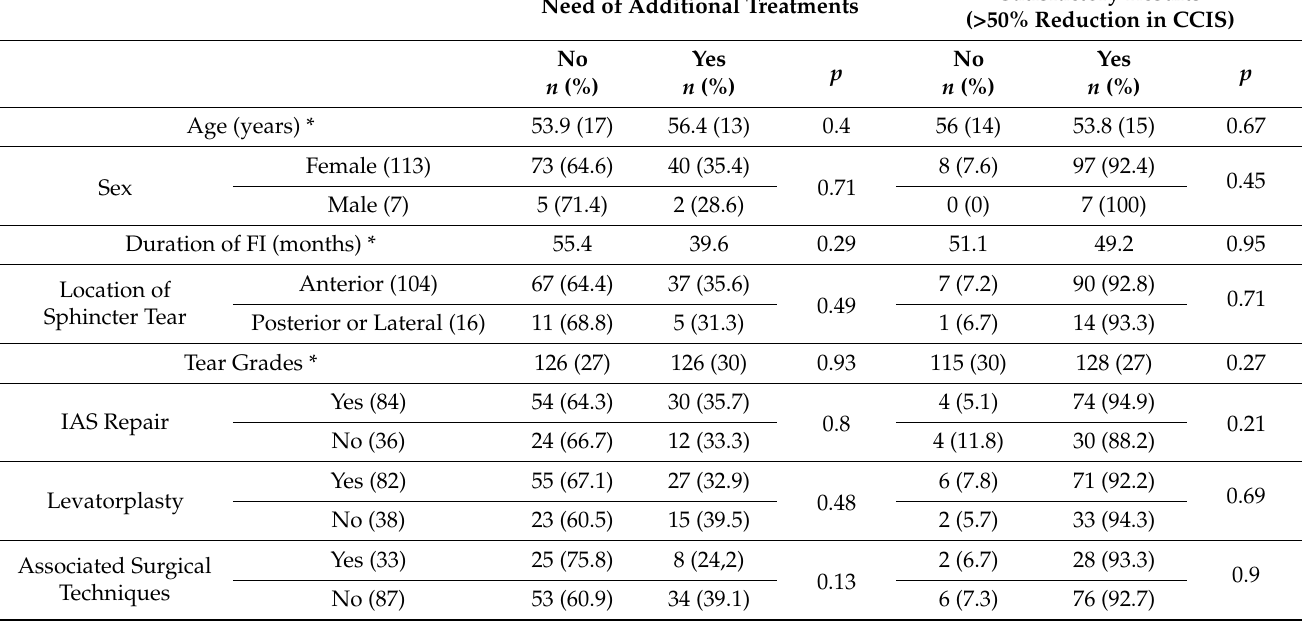
Table 3. Univariate analysis of possible factors that could influence clinical results in terms of additional treatment necessity or global success at end follow-up